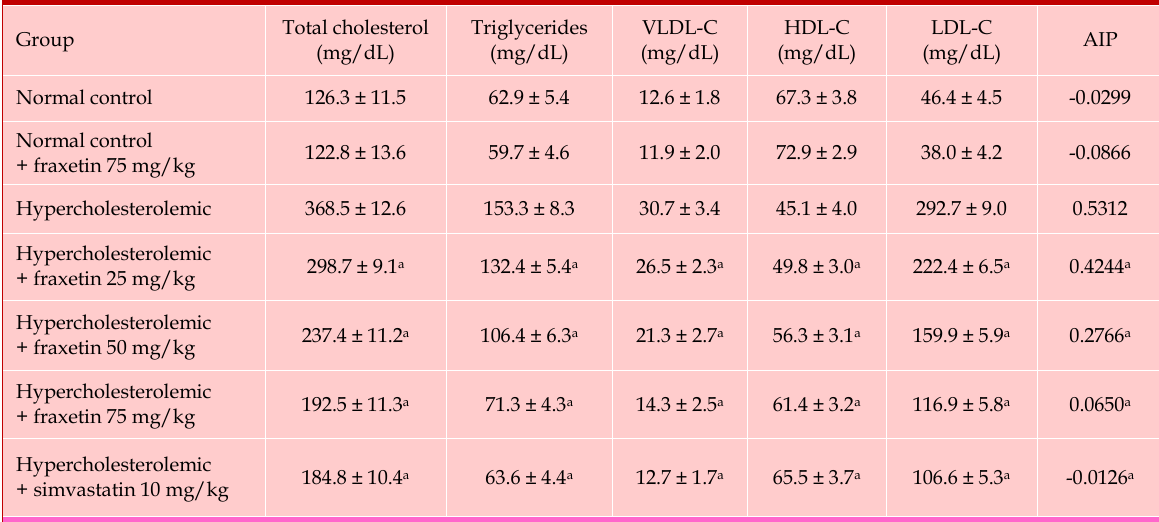
The values are mean ± SD of 6 animals in each group. AIP- Atherogenic Index of Plasma; a The difference between treated and hypercholeterolem-